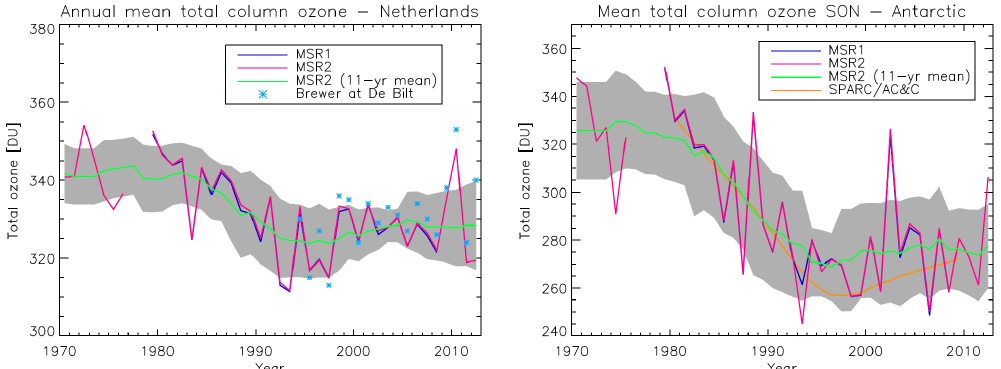
Figure 3. Mean ozone values for the period 1970–2012 above De Bilt (5.18 ◦ E, 52.1 ◦ N) (left, annual mean) and the Antarctic (right, mean of September–November). The blue line shows the results for MSR1, the red line for MSR2, the grey area shows the variability of the monthly means within a year (left) or 3 months (right). The green line presents an 11-year running mean for de Bilt (left) and the orange line shows the model values of SPARC/AC&C (Cionni et al., 2011) for Antarctic (right).